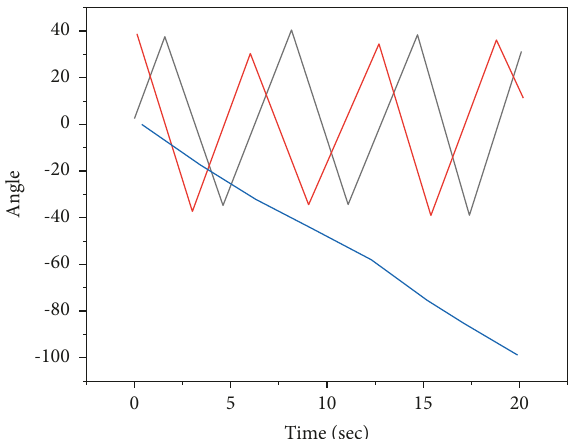
Figure 6: Constraint of self-occlusion shadow on horizontal profile.